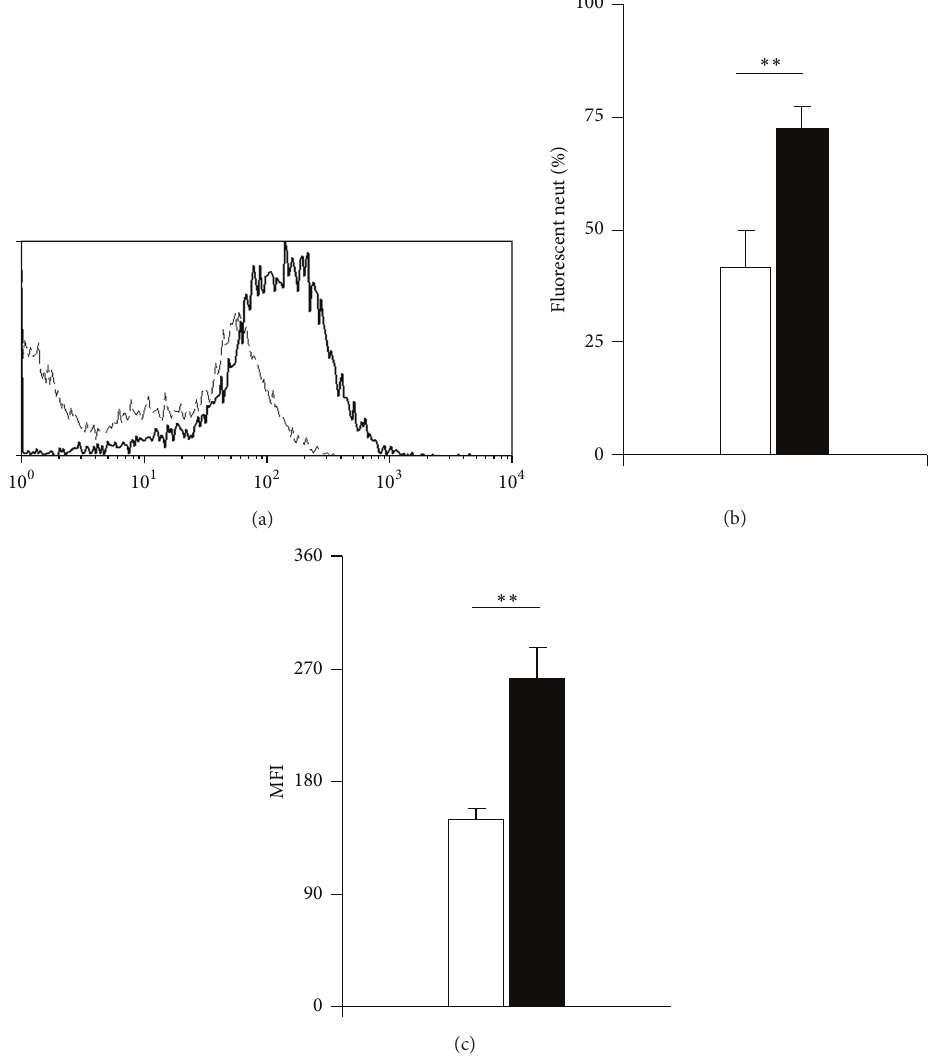
Figure 8: Flow cytometric analyses of peritoneal lavage leukocytes. (a)–(c) Interaction between fluorescent bacteria and neutrophils from eotaxin-injected and control mice. BALB/c mice were injected with eotaxin 50 ng/cavity i.p. Controls received RPMI. After 4h, peritoneal lavage fluid was collected from both groups. After counting neutrophils, fluorescent, viable E. coli bacteria were mixed with leukocytes at a 400 :1 bacteria/neutrophil ratio and further incubated for 30 min before washing to eliminate unbound bacteria, and analysis of neutrophil- associated fluorescence by flow cytometry. (a) Representative profiles of eotaxin-induced (thick, continuous line) and RPMI-induced (thin, interrupted line) neutrophil-associated fluorescence. (b) Fraction of the neutrophils positive for fluorescent bacteria in RPMI-induced (open bar) and eotaxin-induced (black bar) peritoneal leukocyte populations (mean ± SEM); (c) mean fluorescent intensity of neutrophils in the same samples (mean ± SEM). Data from 4-5